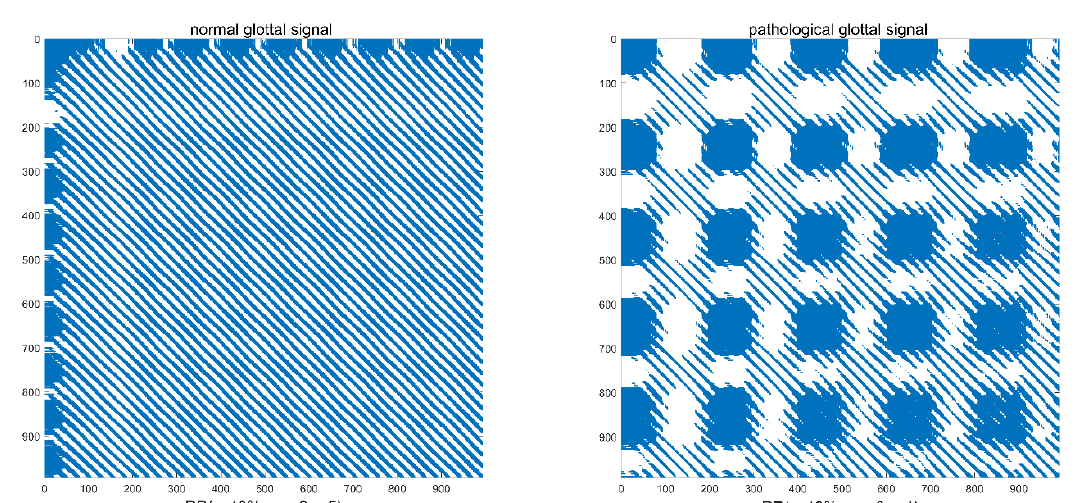
Figure 5. RPs of normal glottal signal and pathological glottal signal.